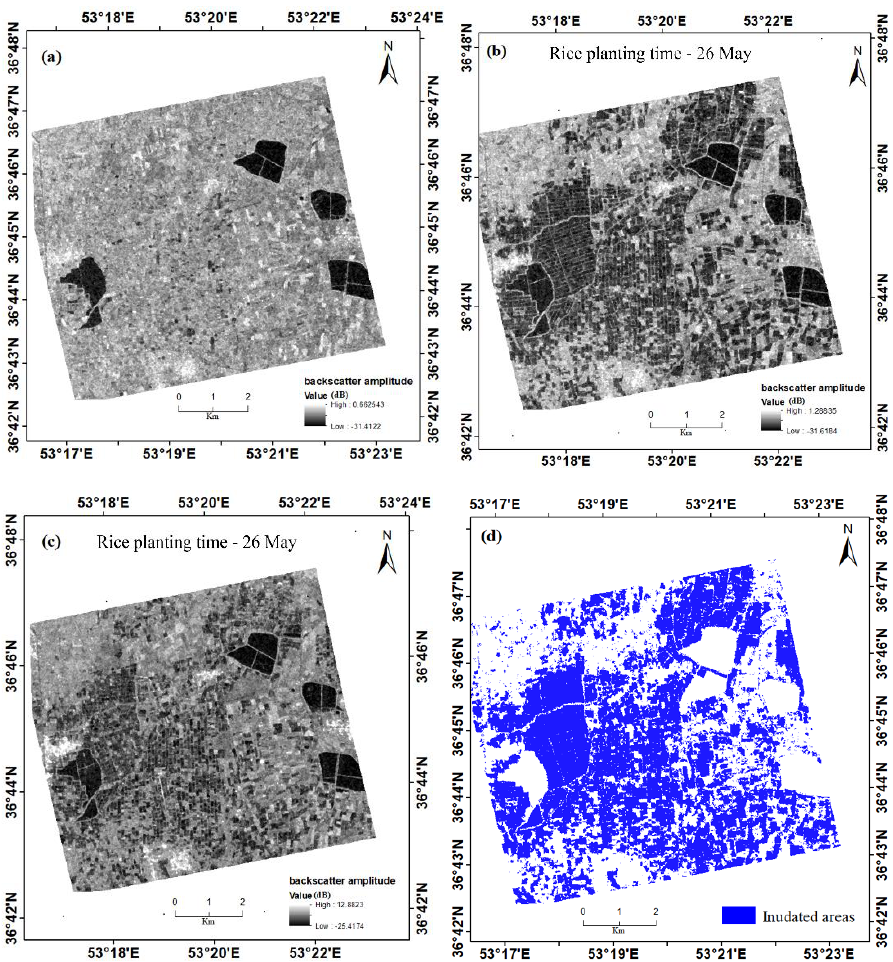
Figure 4. Study area, (a) before planting rice, (b) VH polarization, (c) VV polarization, and (d) inundated